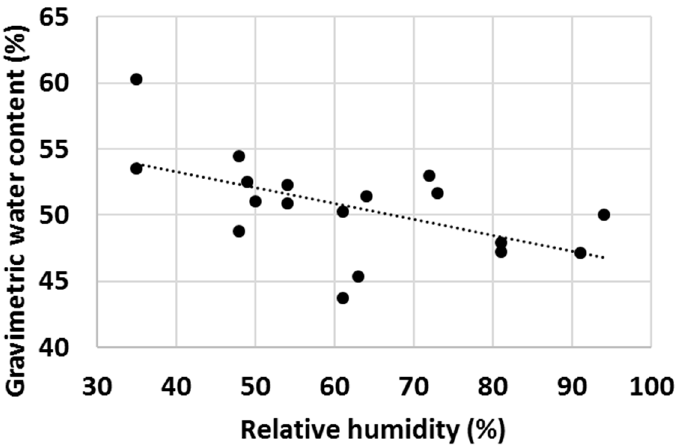
Figure 17. Gravimetric water content of OPC after 1 min hydration at various levels of relative hu- midity.